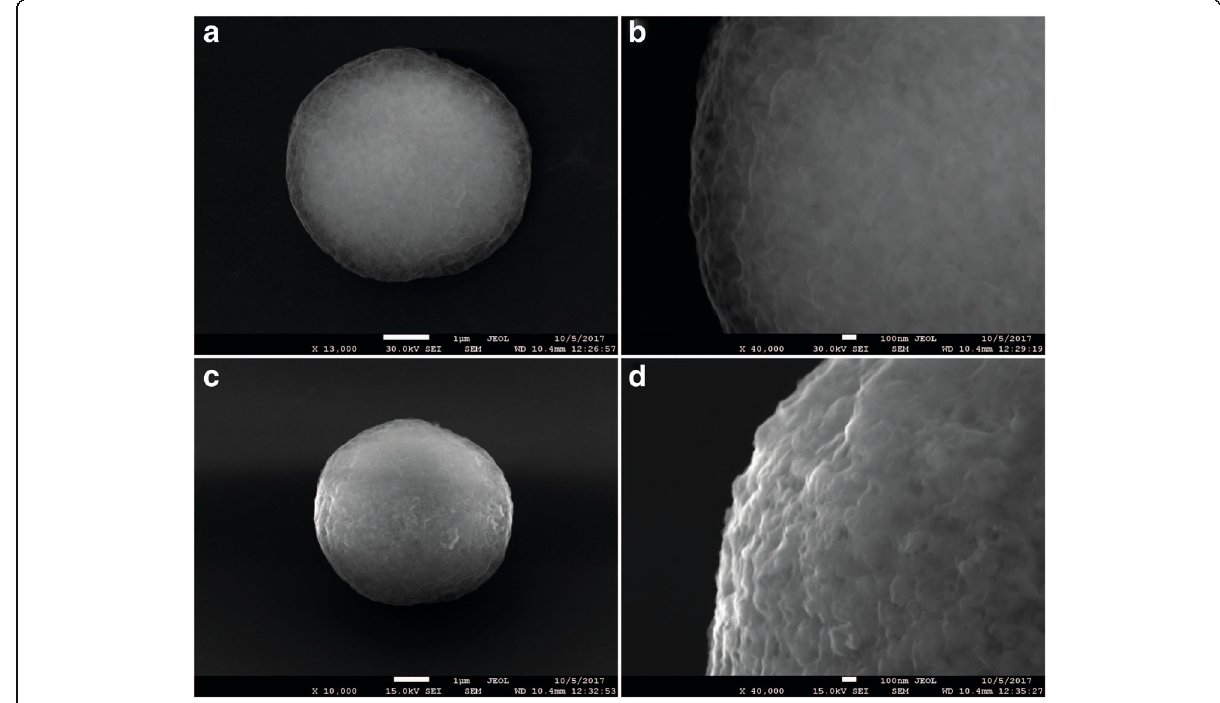
Fig. 4 Scanning electron microscopy images of calcium carbonate microparticles after application of four ( a , b ) and ten ( c , d ) polyelectrolyte